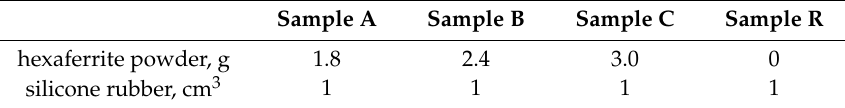
Table 2. Composite samples with di ff erent weight-percent filling of the